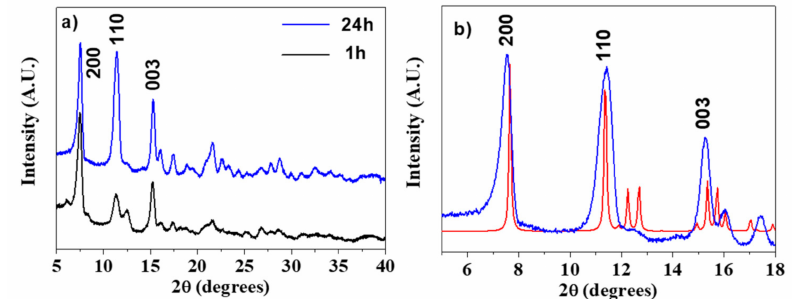
Figure 3. ( a ) X-ray powder patterns of the Gd-NDC networks synthesized for 1 and 24 h; ( b ) assign- ment of the [Gd 2 (NDC) 3 (H 2 O)] · 2(H 2 O) pattern (blue line) in comparison with the Mercury derived powder pattern of the homologous [Yb 2 (NDC) 3 (H 2 O)] · 2(H 2 O) (red line, ref. [48]).